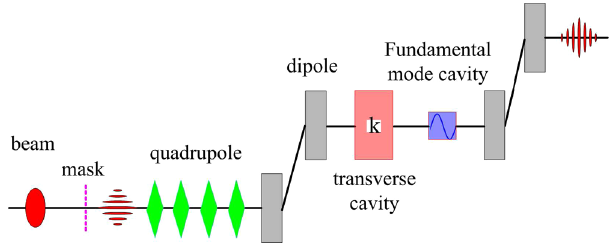
FIG. 5. Schematic of a beam line to generate optical micro- bunch based on PSEX.